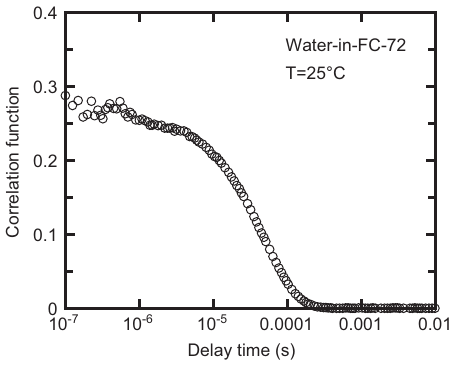
Figure 9 The correlation function of the scattered light for the 12 vol.% water in the FC-72 nanoemulsion fluids. The measurements were taken by a Photocor-Complex DLS instrument.